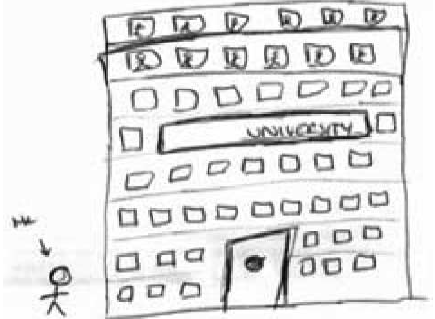
Figure 1. Image from journal